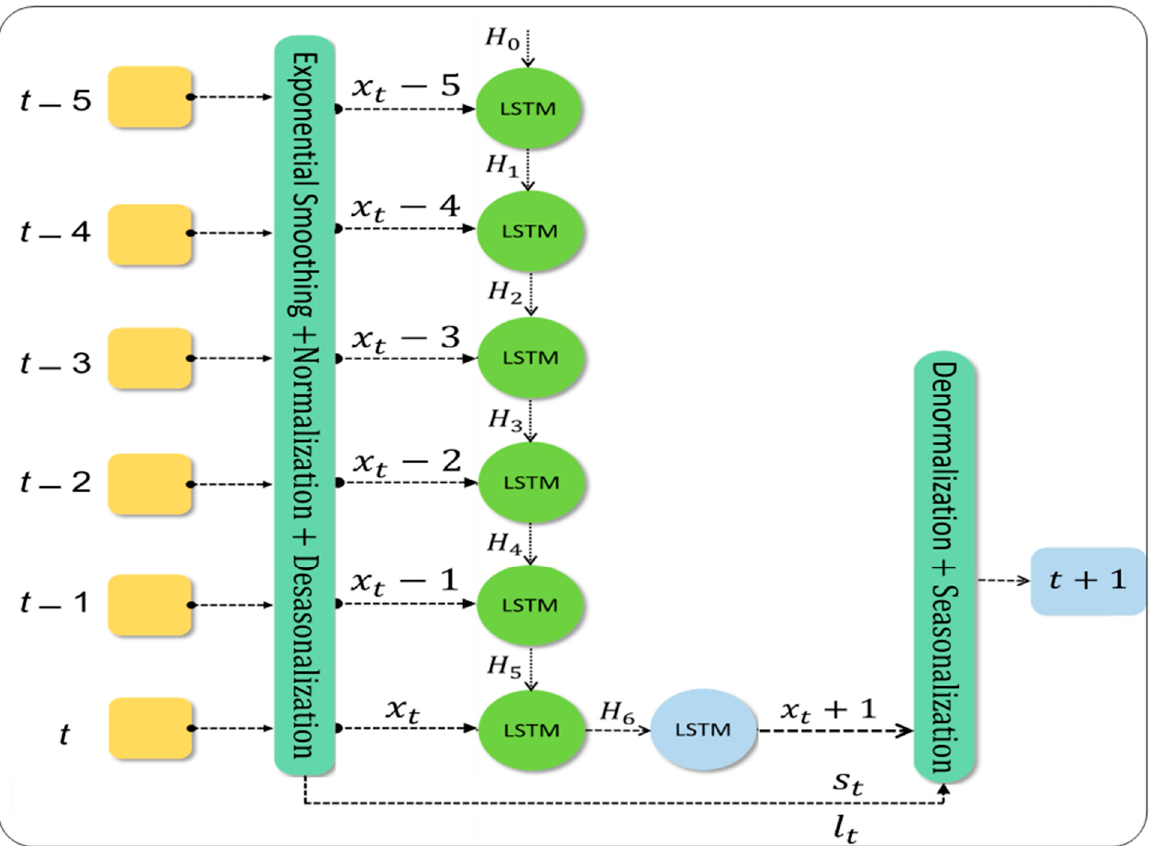
Figure 4. Exponential smoothing and LSTM architecture.